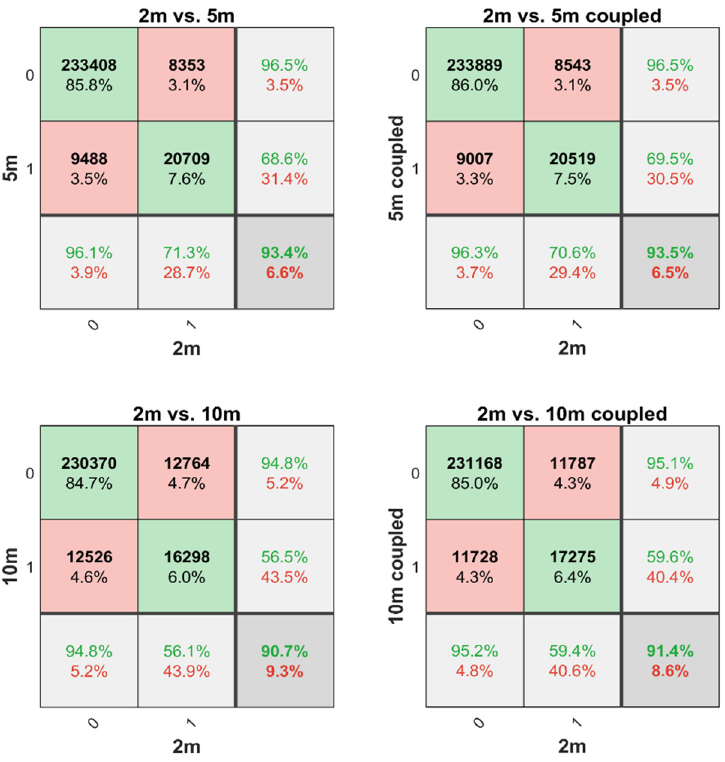
Figure 12. Confusion matrix considering all cells in the urban dense area.